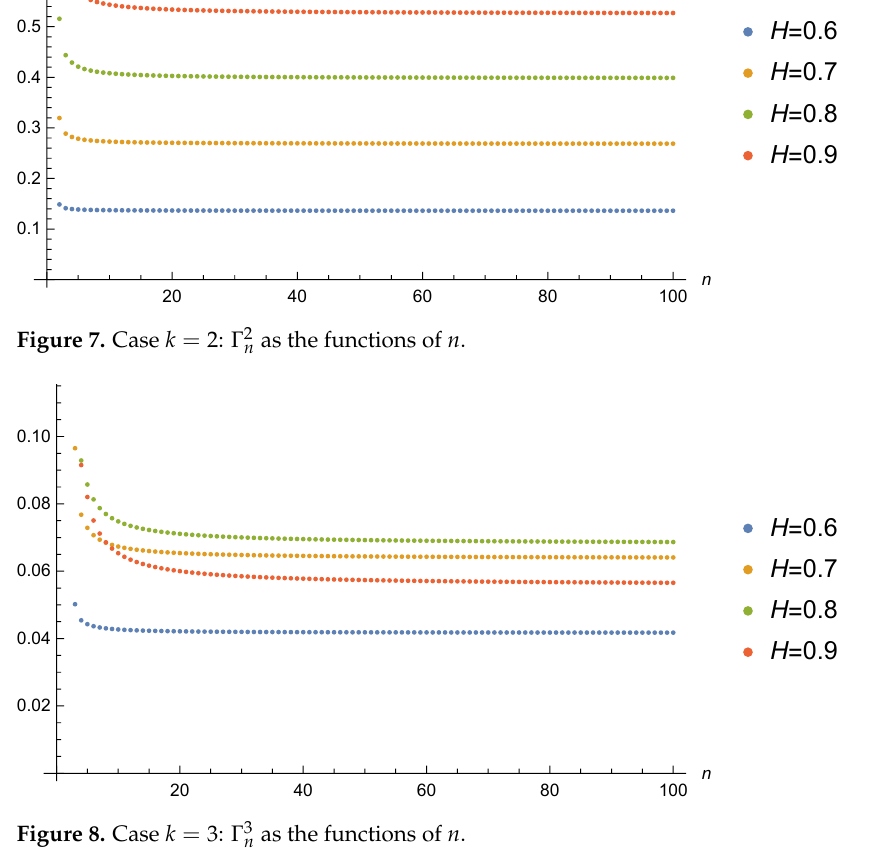
Figure 8. Case k = 3: Γ 3 n as the functions of n